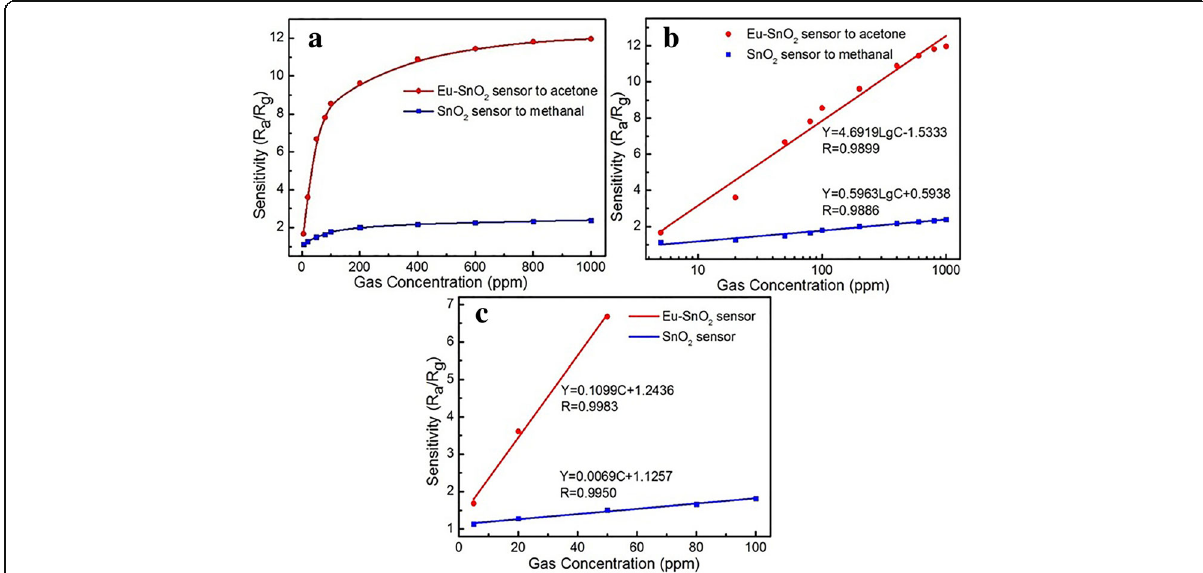
Fig. 6 The curves of a response versus gas concentration, b response versus the logarithm of the concentration, and c response versus gas concentration in low range for the two sensors